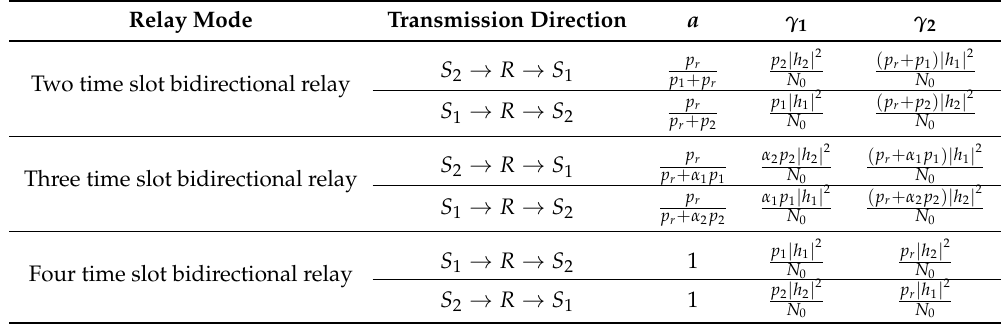
Table 2. Parameter values for the three relay